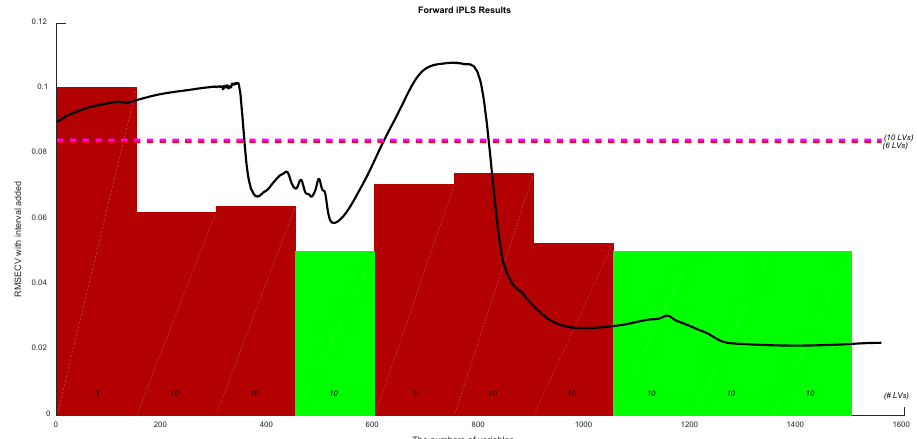
Fig. 7. The results of variables